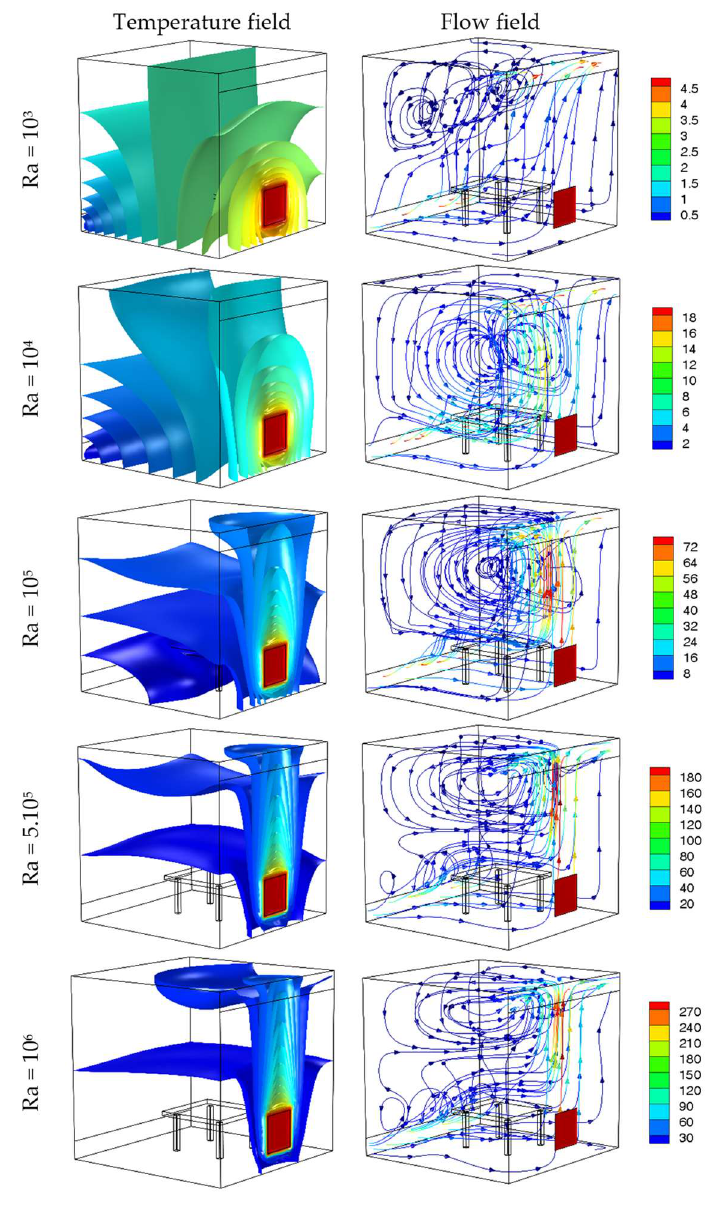
Figure 5. Effect of Rayleigh number variation on the distribution of temperature iso-surfaces and particle trajectories for a heat source position as indicated in case 1.